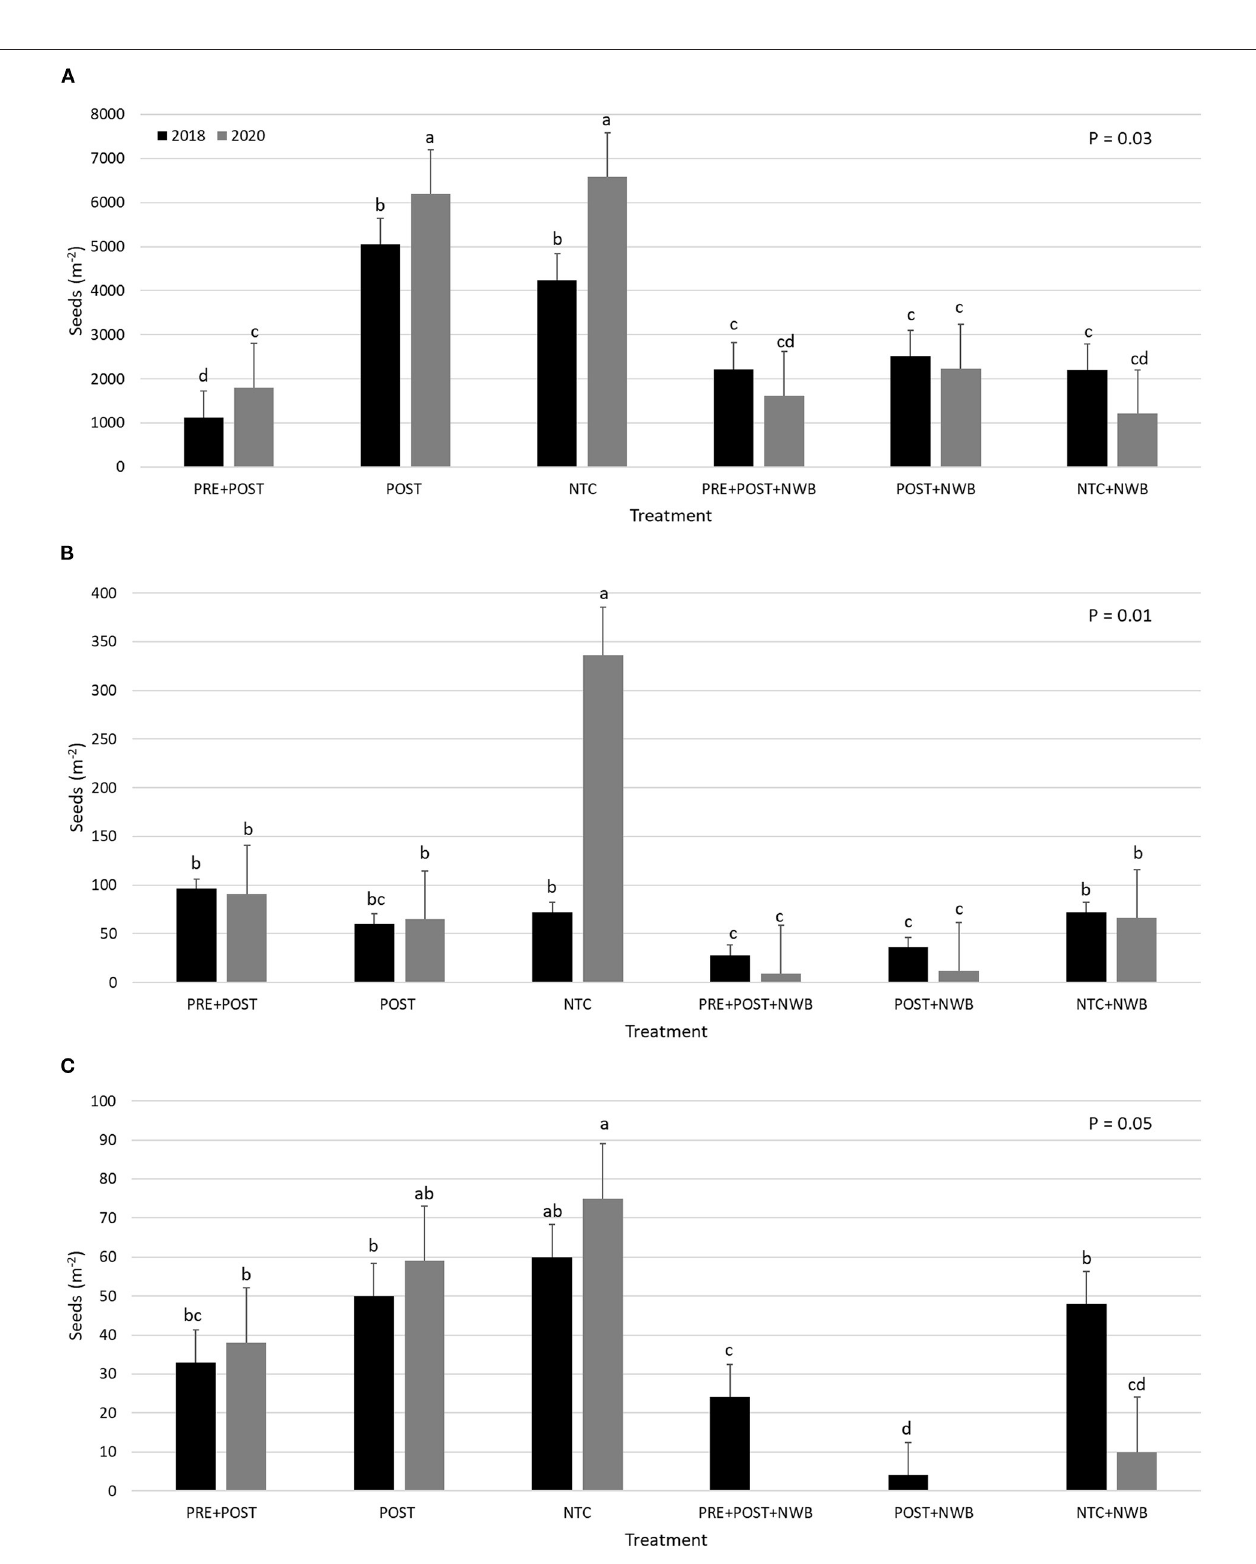
FIGURE 1 | Changes in the soil seedbank from 2018 to 2020 for (A) Amaranthus palmeri , (B) Echinochloa crus-galli , and (C) Ipomoea species based on the interaction of herbicide program and with or without narrow-windrow burning. Sites were pooled since there are no significant difference between them. Means followed by the same letter are not statistically different according to Fisher’s protected LSD ( α = 0.05).